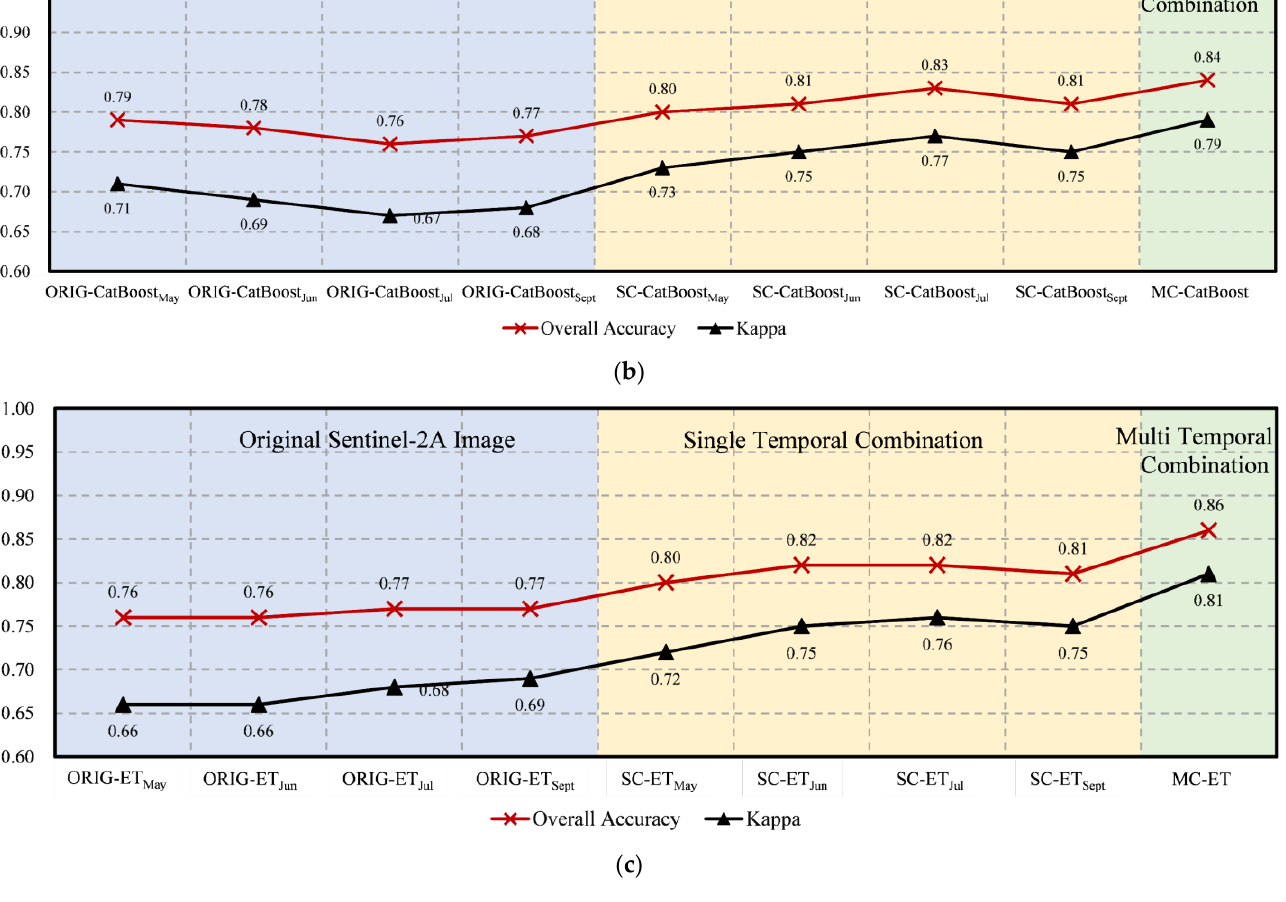
Figure 6. OA and kappa of different classification schemes. Classification accuracy based on ( a ) RF, ( b ) CatBoost, and ( c ) ET algorithms. The F1 scores for rice based on the different classification schemes are shown in Table 6.